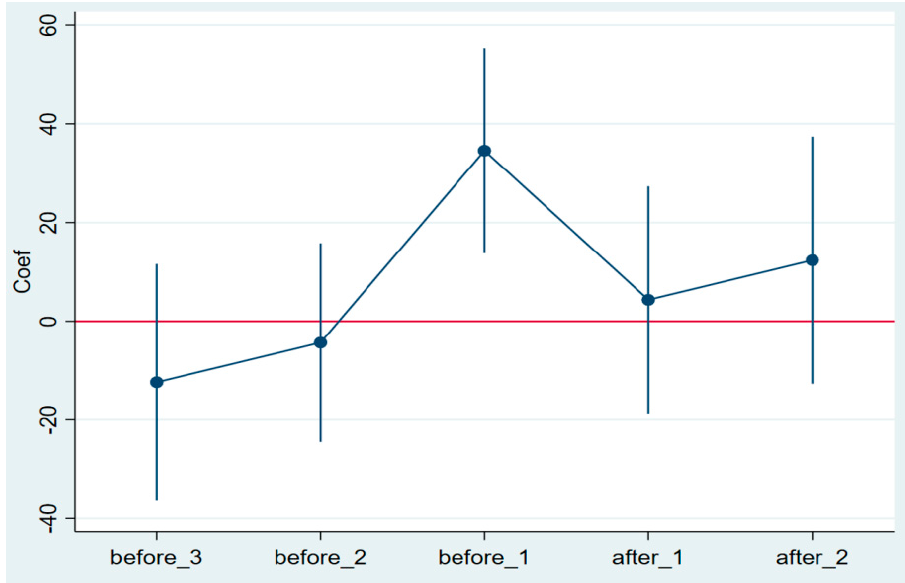
Figure 3. Coefficient trend change. Table 9. Placebo test